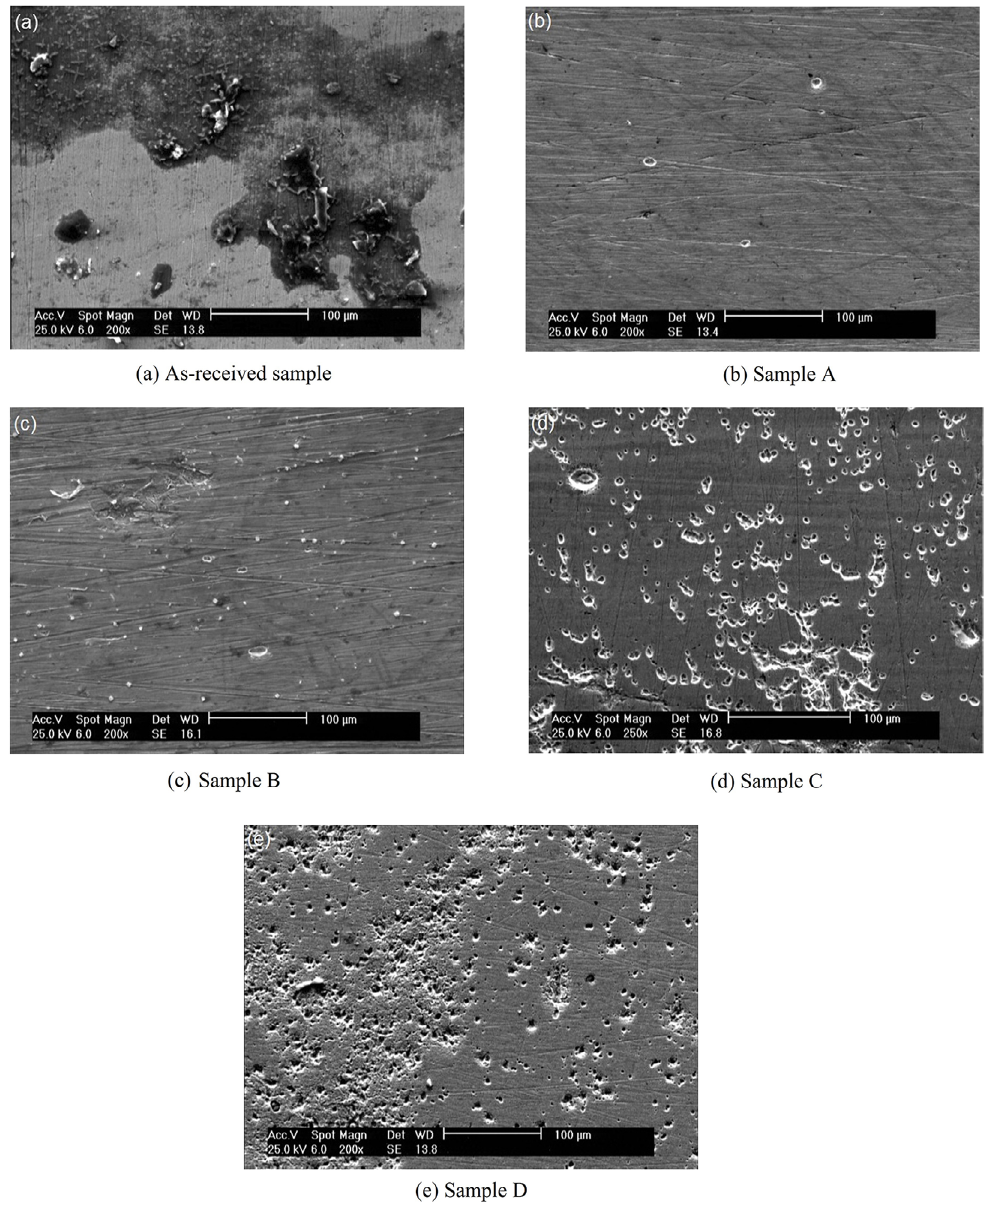
Figure 9. SEM micrographs of corroded samples after potentiodynamic polarization test. Table 5. The results obtained from corrosion tests performed in 3.5% NaCl solution.